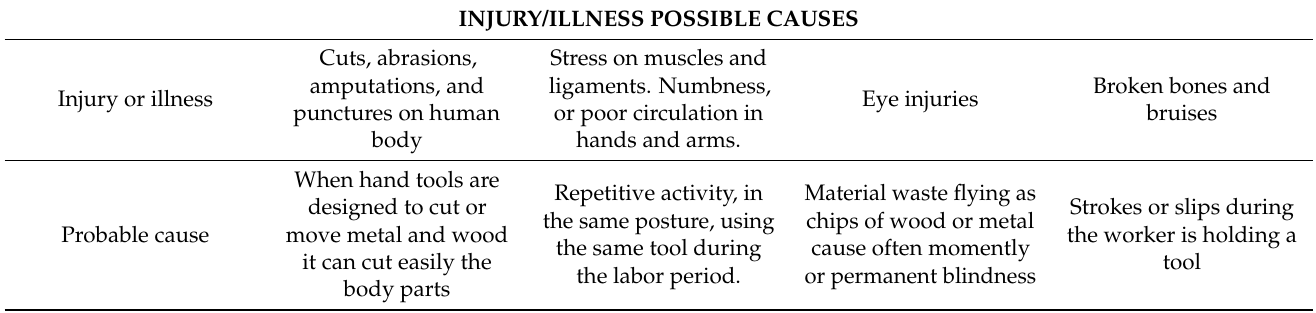
Table 4. Injury and Possible Causes